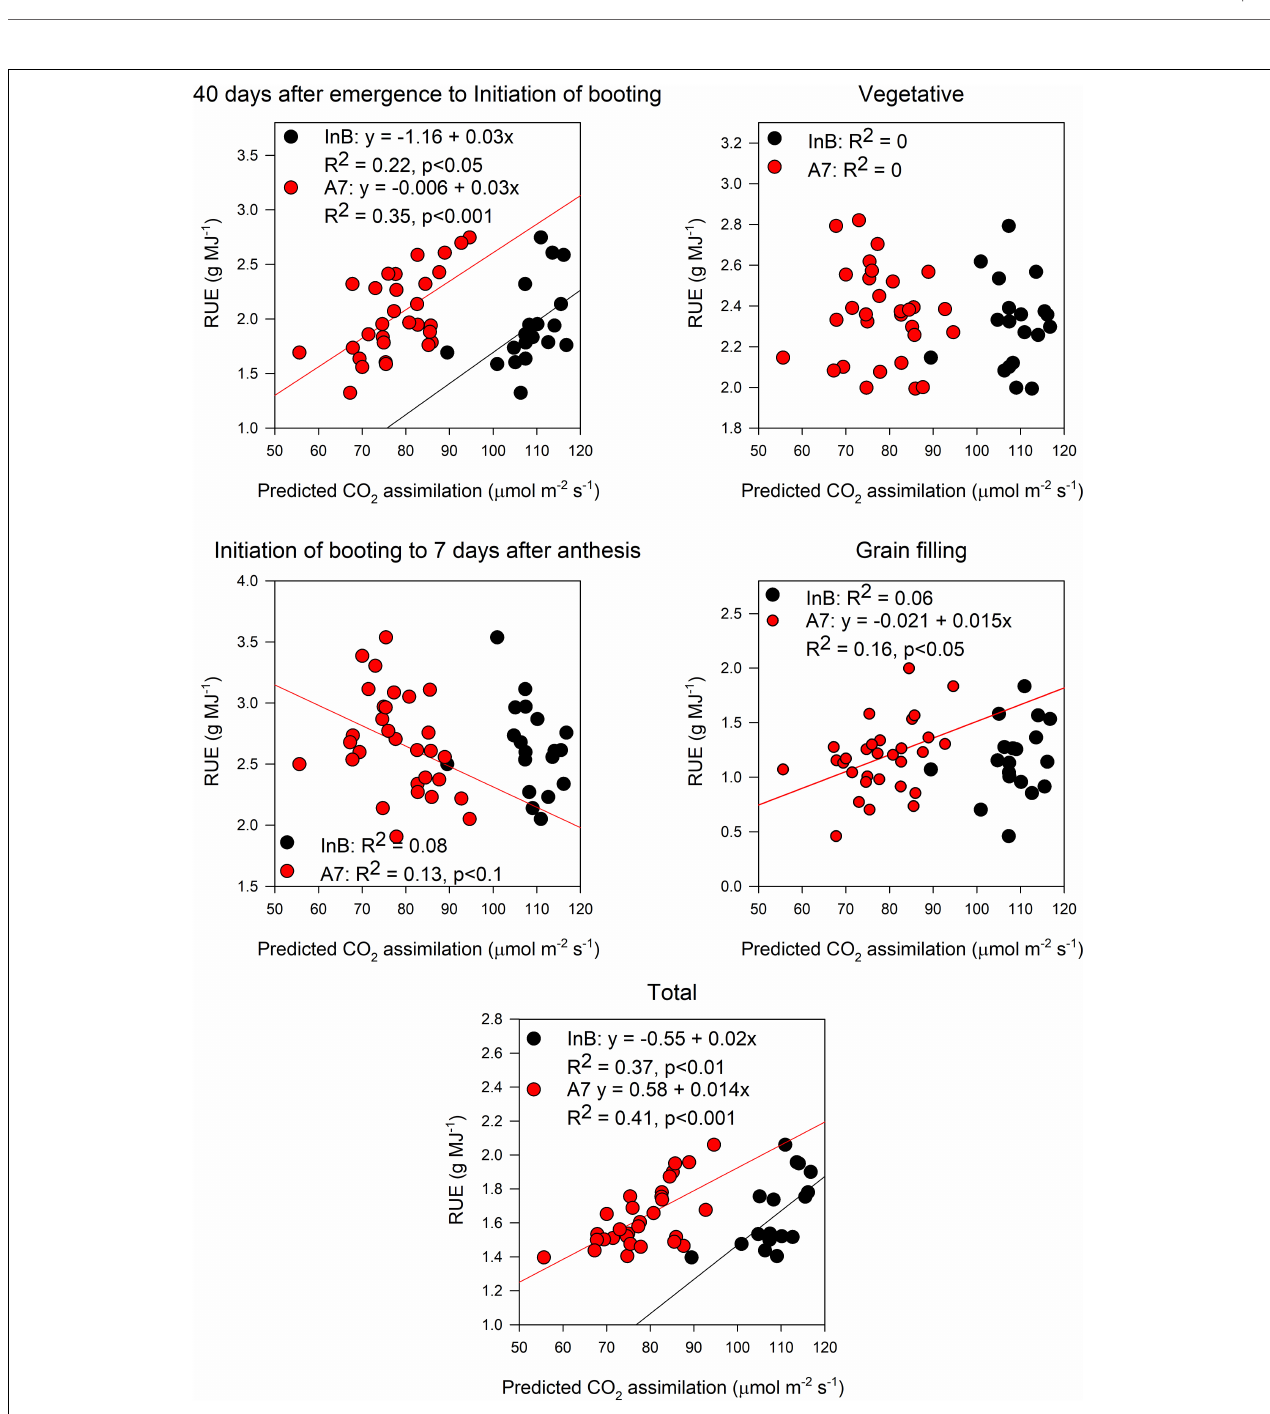
FIGURE 7 | Relationship between radiation use efficiency measured at different growth periods and predictions of canopy assimilation estimated from the PLSR models. Black dots represent predictions from initiation of booting and red dots predictions from 7 days after anthesis. Data shown are the observed vs predicted bilinear unbiased estimator (BLUEs) in 2 years of study (initiation of booting, n = 19) and 3 years of study (7 days after anthesis, n = 30). Lines represent the linear regression when statistically significant relationships were